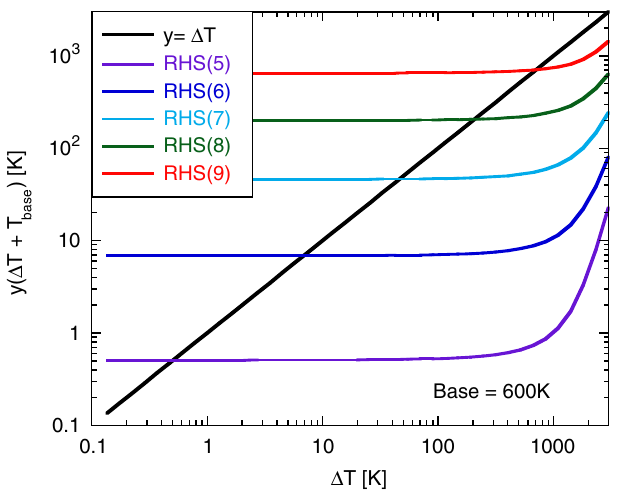
FIG. 16. (Color) Graphical representation of Eq. (26) as a func- tion of temperature: the left-hand side is the solid black line. The right-hand side, or sum of the heating terms, are the solid colors. The base of the asperity is held at a fixed temperature of 600 K. The number in parentheses in the legend refers to field in GV = m .